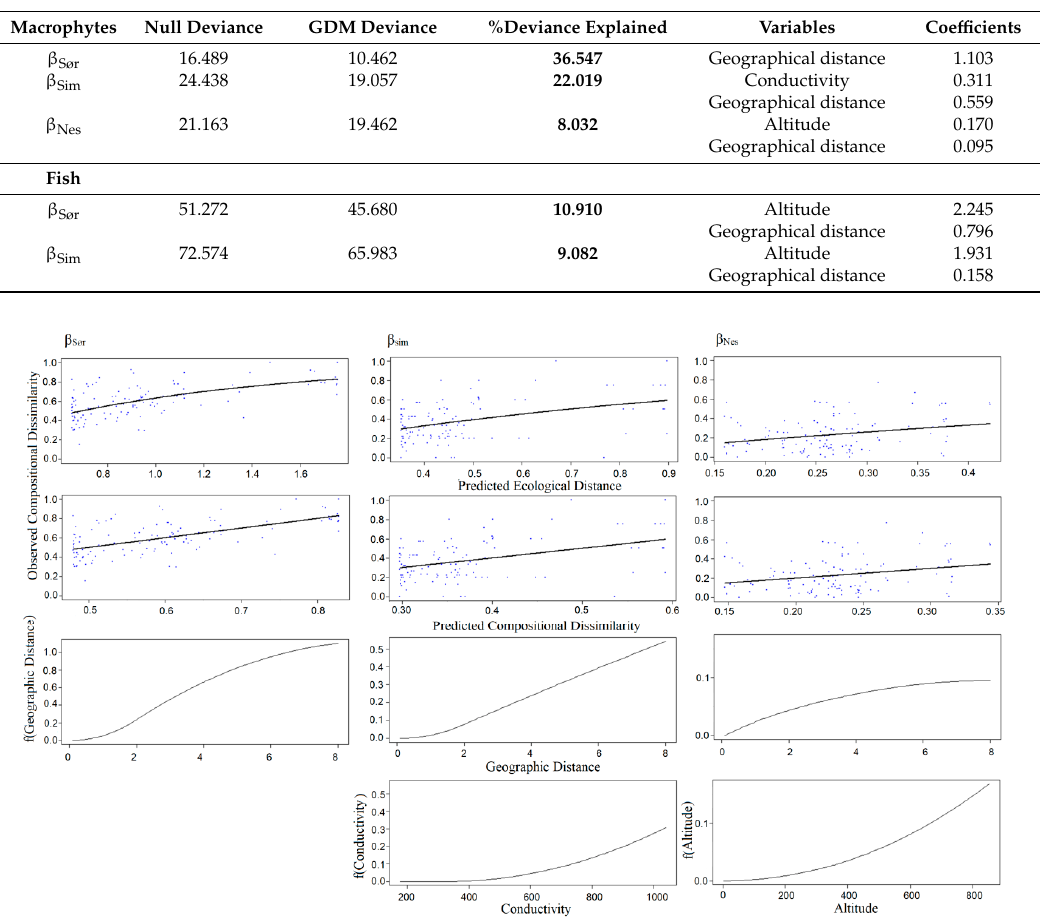
Figure 2. Relationships between the observed macrophyte Sorensen dissimilarity ( β Sør ), the observed macrophyte Simpson dissimilarity ( β Sim ), and the observed macrophyte nestedness component ( β Nes ) with the regression equation from the Generalized Dissimilarity Model (GDM) (termed